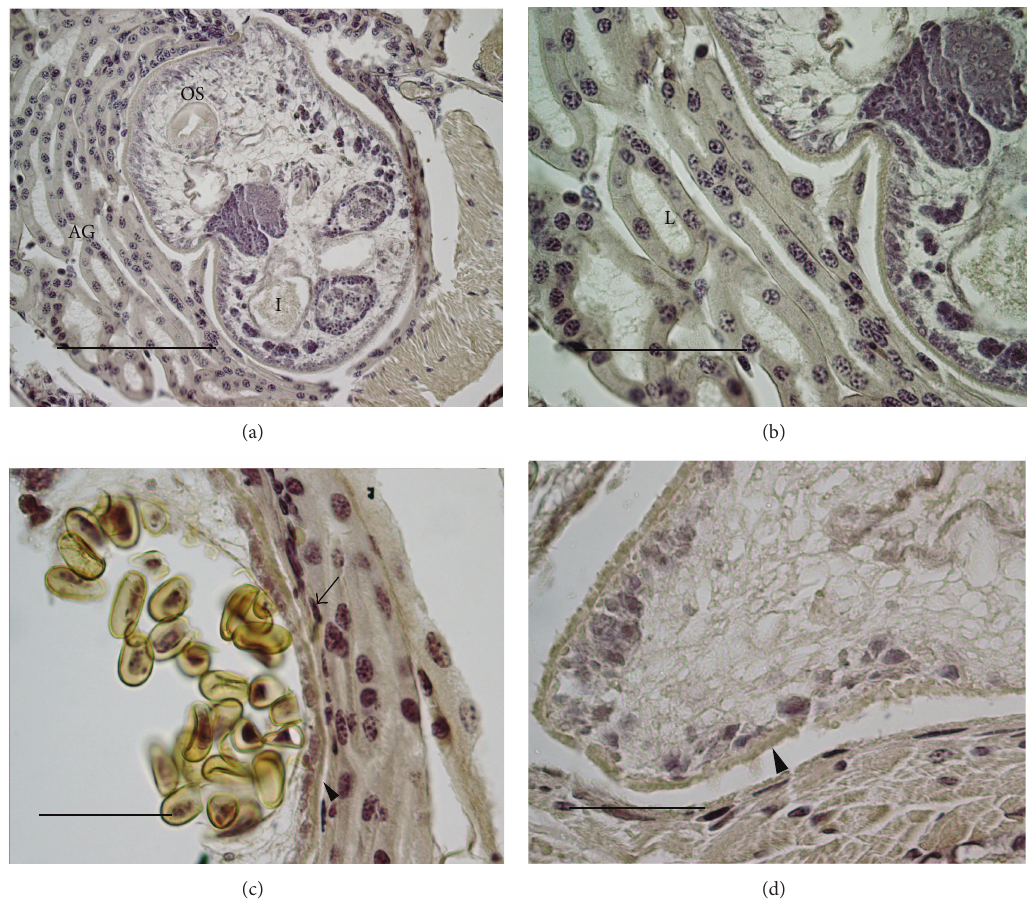
Figure 1: Harris hematoxylin staining of mature Alloglossidium renale within the host. (a) Overview of the parasite. The host antennal gland tubules are on the left side of the image and host striated muscle is on the lower right. (b) An enlargement of (a). (c) Area showing the compression of host antennal gland tubules with compacted nuclei (arrow). The parasite integument has an outer anucleate syncytium (arrowhead). (d) The parasite has consumed the antennal gland. Host muscle is located in the lower part of the image. The parasite integument is indicated (arrowhead). AG: antennal gland; I: intestine; L: Lumen of antennal gland tubule; and OS: oral sucker. (a) Bar = 200 𝜇 m, (b) bar = 100 𝜇 m, and (c)–(d) bars = 50 𝜇 m. Table 3: Palaemonetes kadiakensis tissue staining table. Tubule cell Tubule cell basal Tubule cell Tubule cell Lumen of Interstitial Damaged tubule Stain apical microvilli border nuclei cytoplasm tubule Space